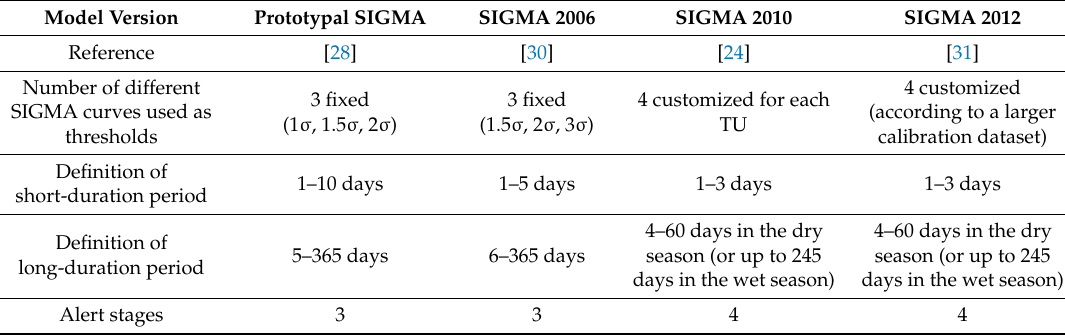
Table 1. Main updates to the decisional